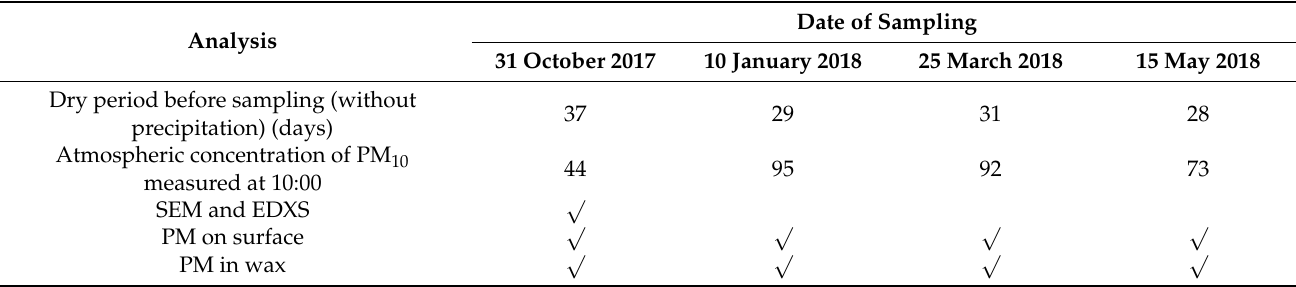
Figure 2. Pictures of representative leaves of 8 broad-leaved evergreen and 2 conifer species plant species taken from sampling sites and used in this study. Table 2. Sampling dates, duration of dry period before collecting leaf samples, atmospheric PM 10 concentration on sampling day, and analytical measurements taken for this